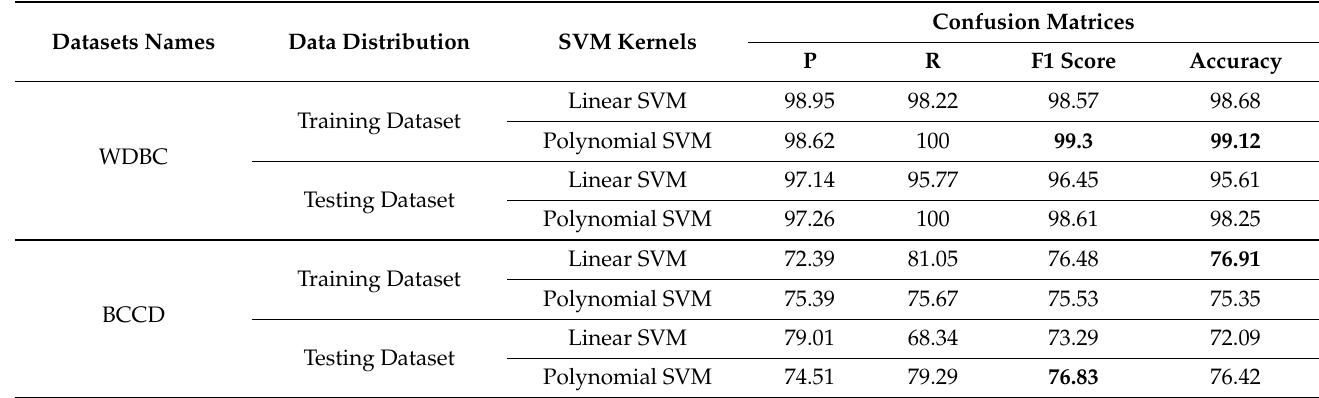
Table 3. Performance Comparison of SVM kernels (Linear and Polynomial) on training and testing dataset of WDBC and BCCD.